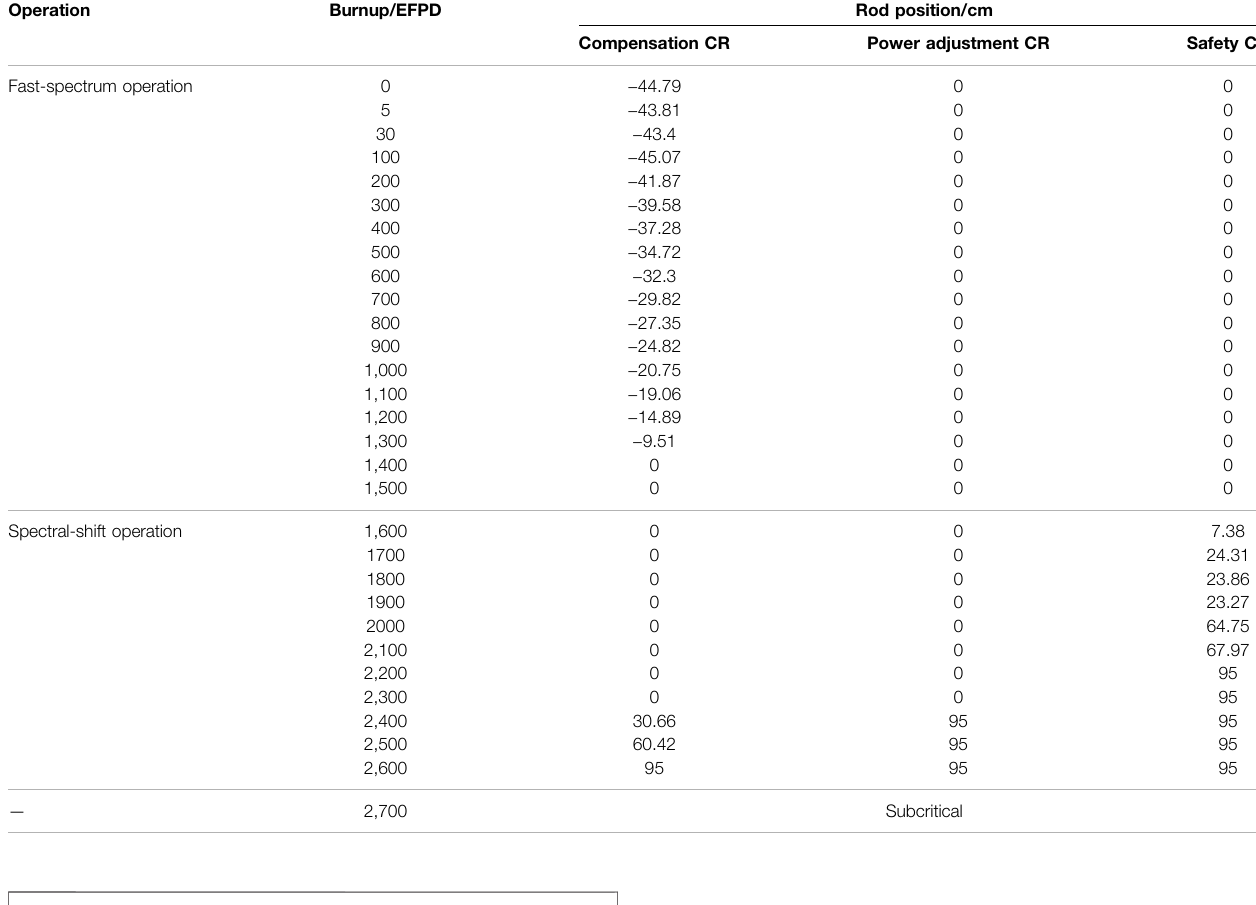
TABLE 3 | Results of the critical rod position for the SLBR-50 spectral-shift control rod design. Operation